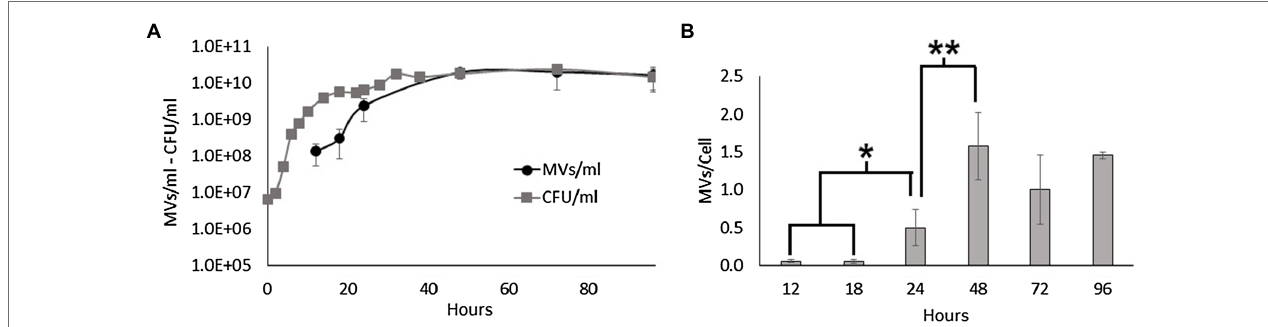
FIGURE 1 | MV production during the growth of Shewanella vesiculosa M7 T . (A) Growth curve of S. vesiculosa M7 T and the MV concentration during growth. Cell concentration was determined by Trypticase soy agar plate counting (CFU/ml). MV concentration was measured by flow cytometry with FM4-64 labeling, and events were extrapolated with the 100 nm FluoSpheres ™ . (B) Graph representing the ratio or number of MVs secreted per cell along the growth curve. n = 3, Statistical analysis was done using the ANOVA test, * and ** p < 0.05.